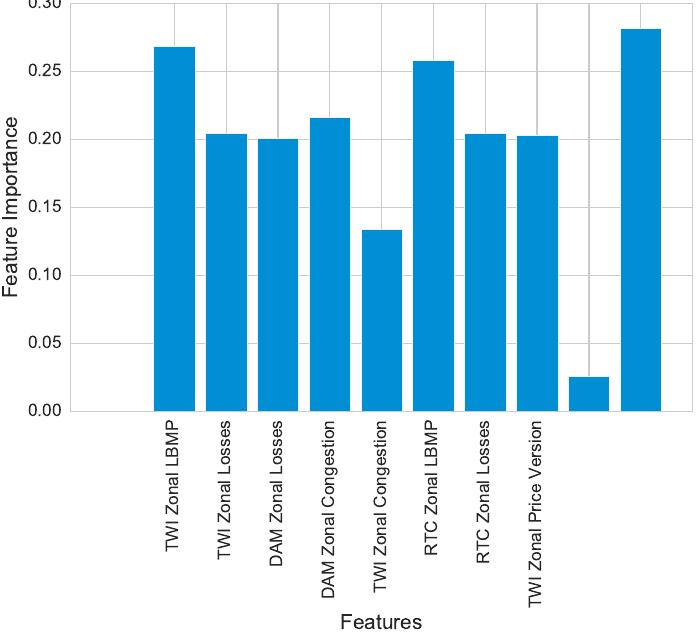
Figure 13. Feature Importances for